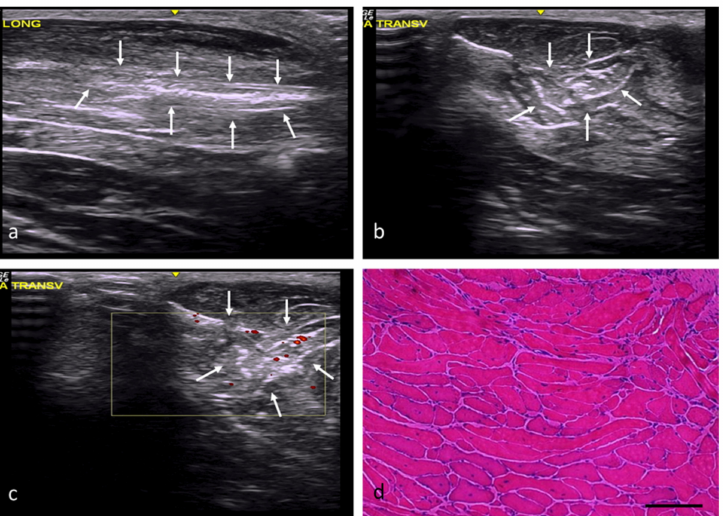
Figure 4. AT group. ( a ) Longitudinal axis, with images of a hyperechoic injury with poorly defined margins, an imprecise morphology, and a slightly distorted echostructure, demarcated by white arrows. ( b ) Transverse axis, with images of an injury with slightly increased echogenicity, poorly defined margins, and an imprecise morphology. ( c ) Transverse section assessed by power Doppler imaging, with images of slightly increased intralesional vascularization. ( d ) Transverse section representative of the muscle histology. H-E. Size scale: 100 µ m.